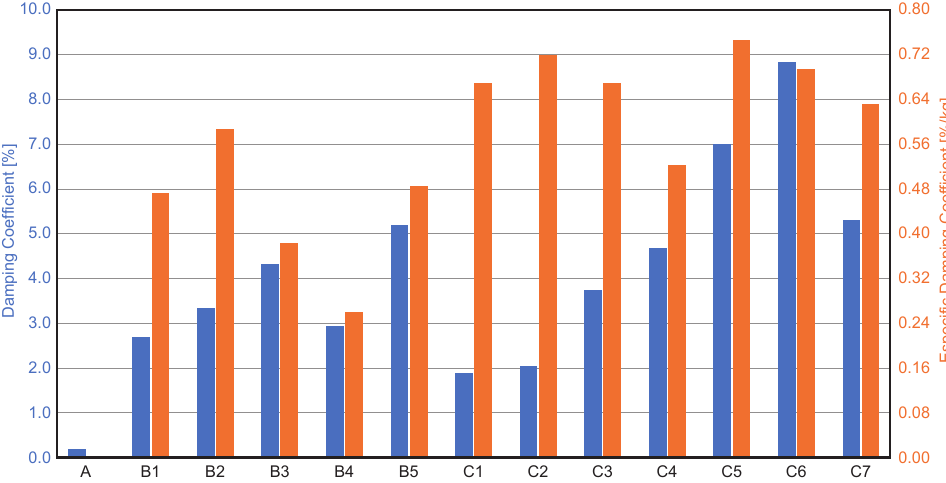
Figure 8. Damping coefficients of the third mode of vibration for the different